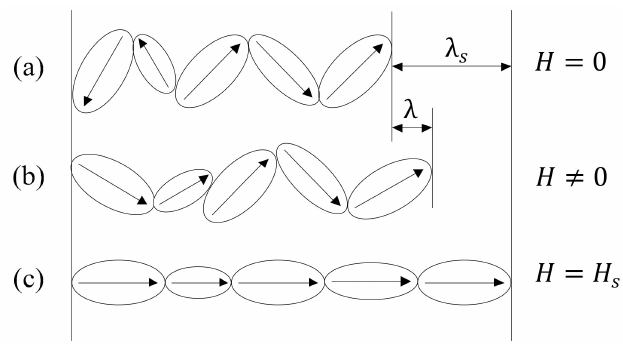
Figure 1. Schematic of the physical mechanism of magnetostriction. ( a ) H = 0; ( b ) H (cid:44) 0 ( c ) H = H s